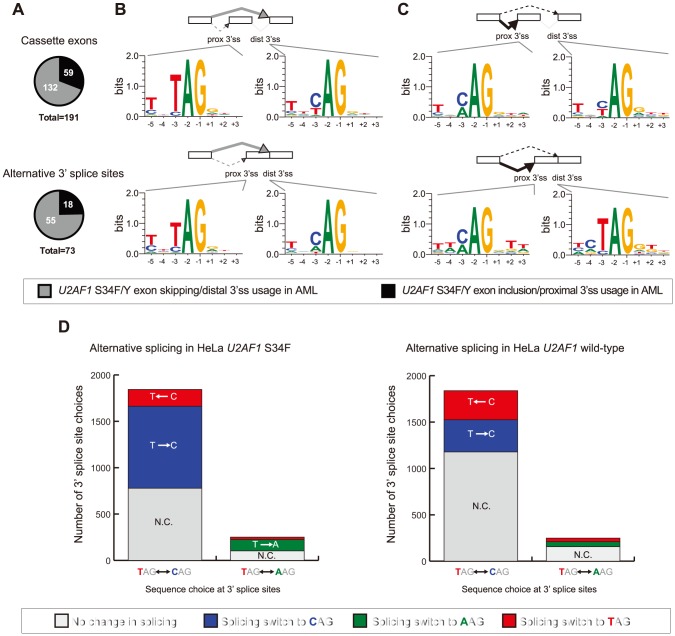
Sequence preferences at altered 3′ splice sites associated with U2AF1 S34F/Y mutation.(A) Proportion of altered cassette exon and alternative 3′ splice site events that show exon skipping versus exon inclusion. (B) Consensus sequence motifs identified at the proximal (prox 3′ss) and distal 3′ splice sites (dist 3′ss) of exon skipping events. (C) Consensus sequence motifs at the proximal and distal 3′ splice sites of exon inclusion events. Splicing changes of expressed and annotated 3′ splice site choices where the splice site choice is TAG vs. CAG or TAG vs. AAG in (D) HeLa cells+induced U2AF1 S34F or (E) HeLa cells+induced U2AF1 wild-type.